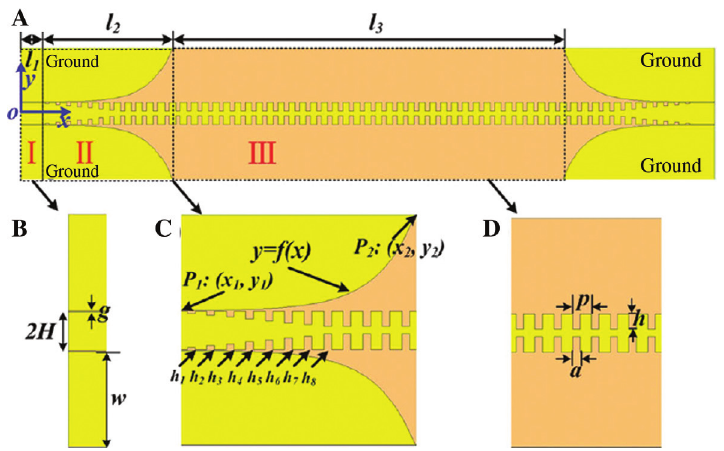
= 10 mm, 1 = 0.5 mm, h = 1 mm, h = 1.5 mm, h = 2 mm, h = 2.5 mm, h = 3 mm, h = 3.5 mm, and h = 4 mm. (D) The 1 2 3 4 5 6 7 8